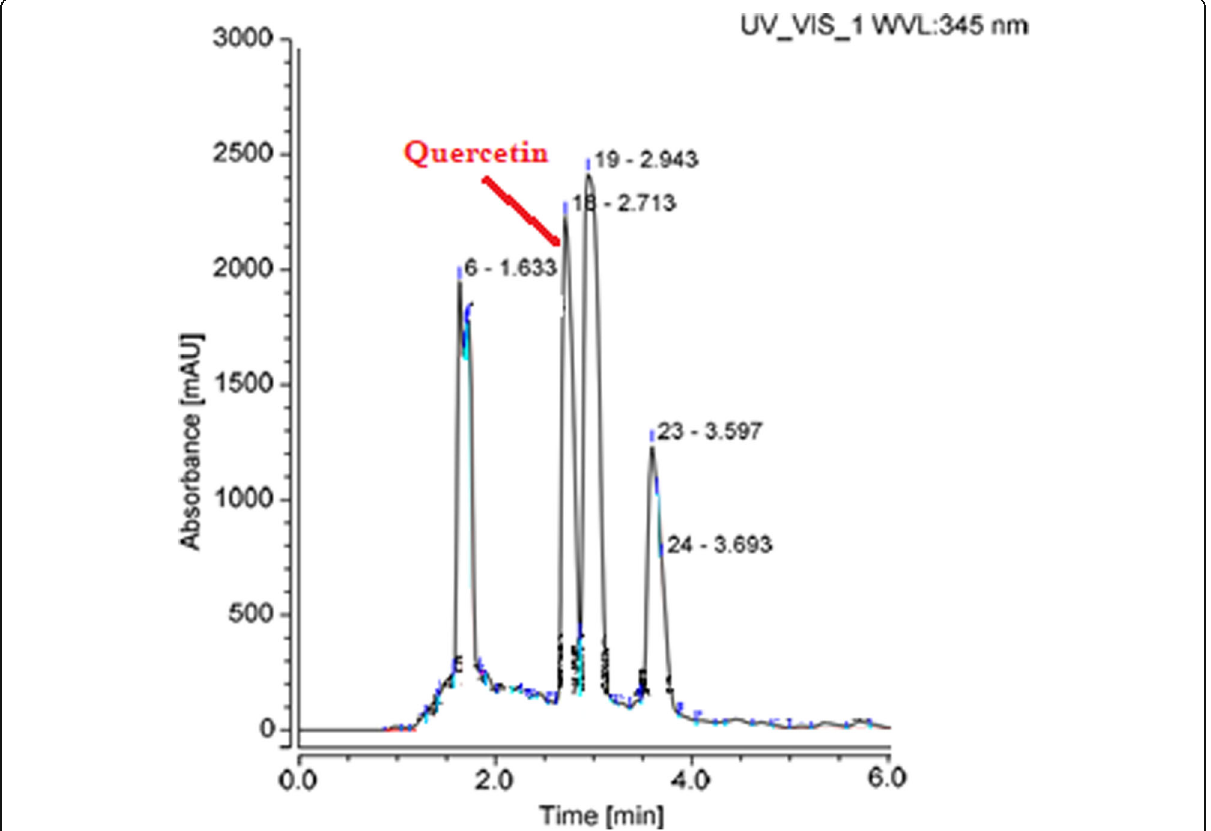
Fig. 3 Qualitative HPLC fingerprint for GC-500. Quercetin appears as peak No 18 at a time of 2.713 min. Quercetin content in the product was 0.31 (± 0.08) % w /